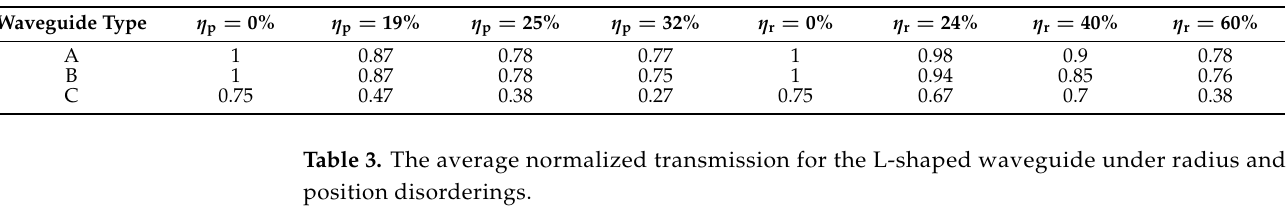
Table 2. The average normalized transmission for the straight waveguide under radius and posi- tion disorderings.